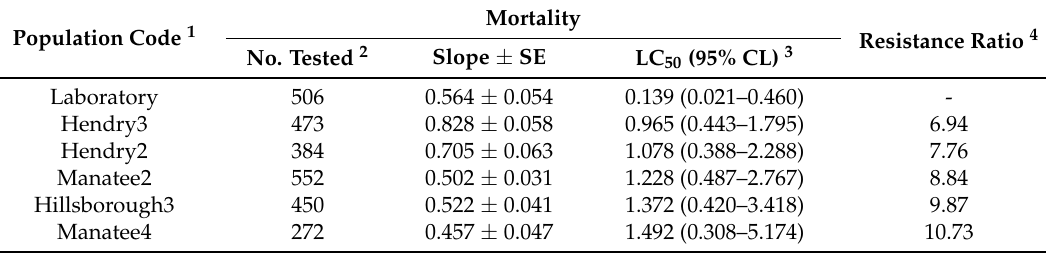
Table 2. Dose response to thiamethoxam and resistance ratios of Bemisia tabaci adults, reared from Florida field-collected populations, as measured by mortality (LC 50 ) with a cut cotton leaf and petiole systemic uptake bioassay in the